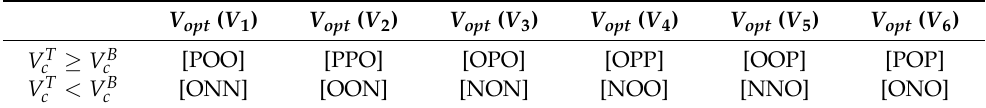
Table 3. Optimal SSs of small VVs for capacitance-voltage